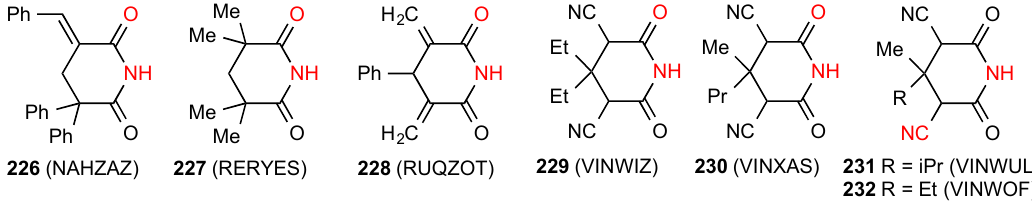
Figure 69. Tetra- and penta-substituted glutarimides showing patterns A and E.